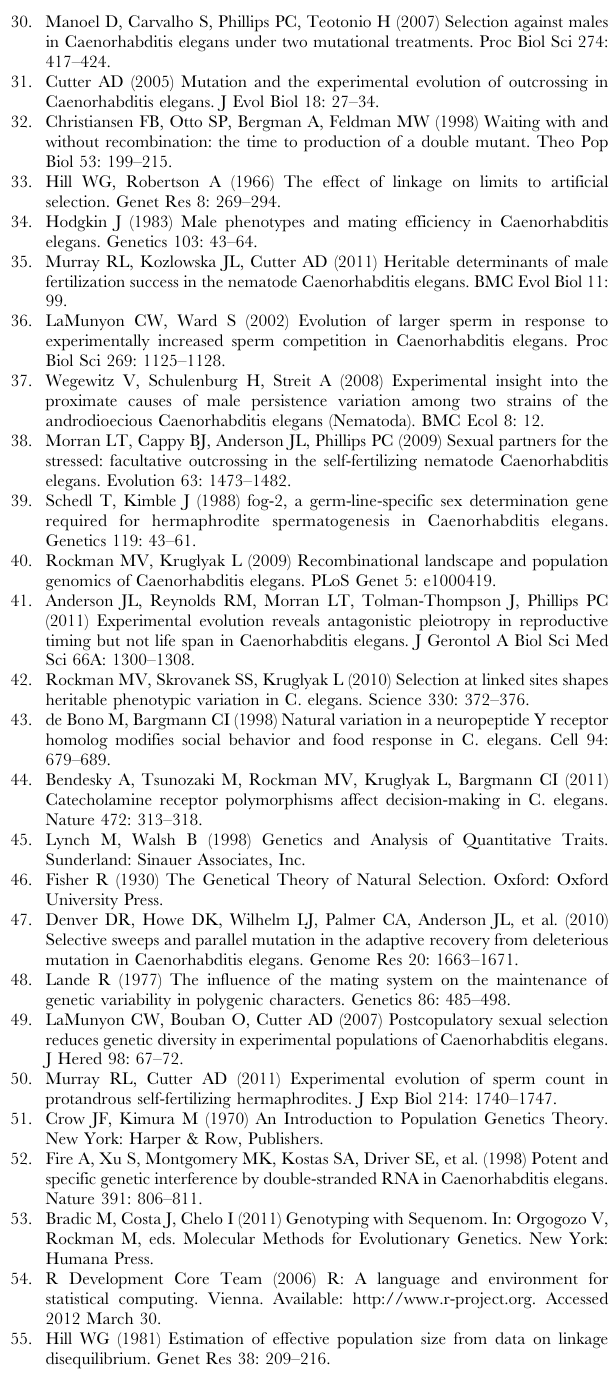
Table S2 SNP information. Table S3 Nested ANOVA of sex ratio and male compet- itive performance under